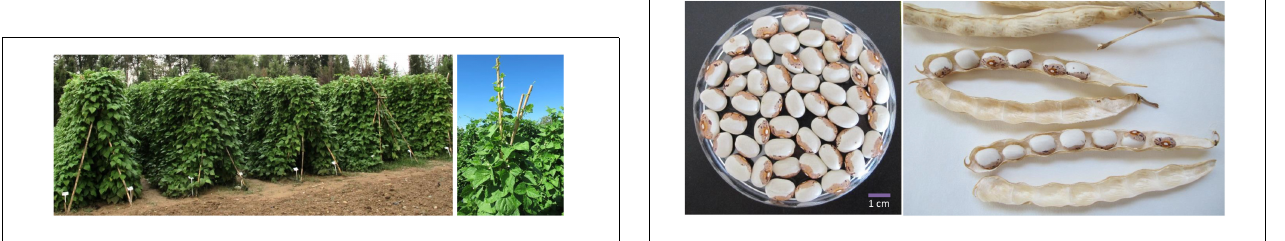
FIGURE 1 | Field trial of Caparrona de Monzón bean. FIGURE 2 | Dry pods and grains of Caparrona de Monzón bean.